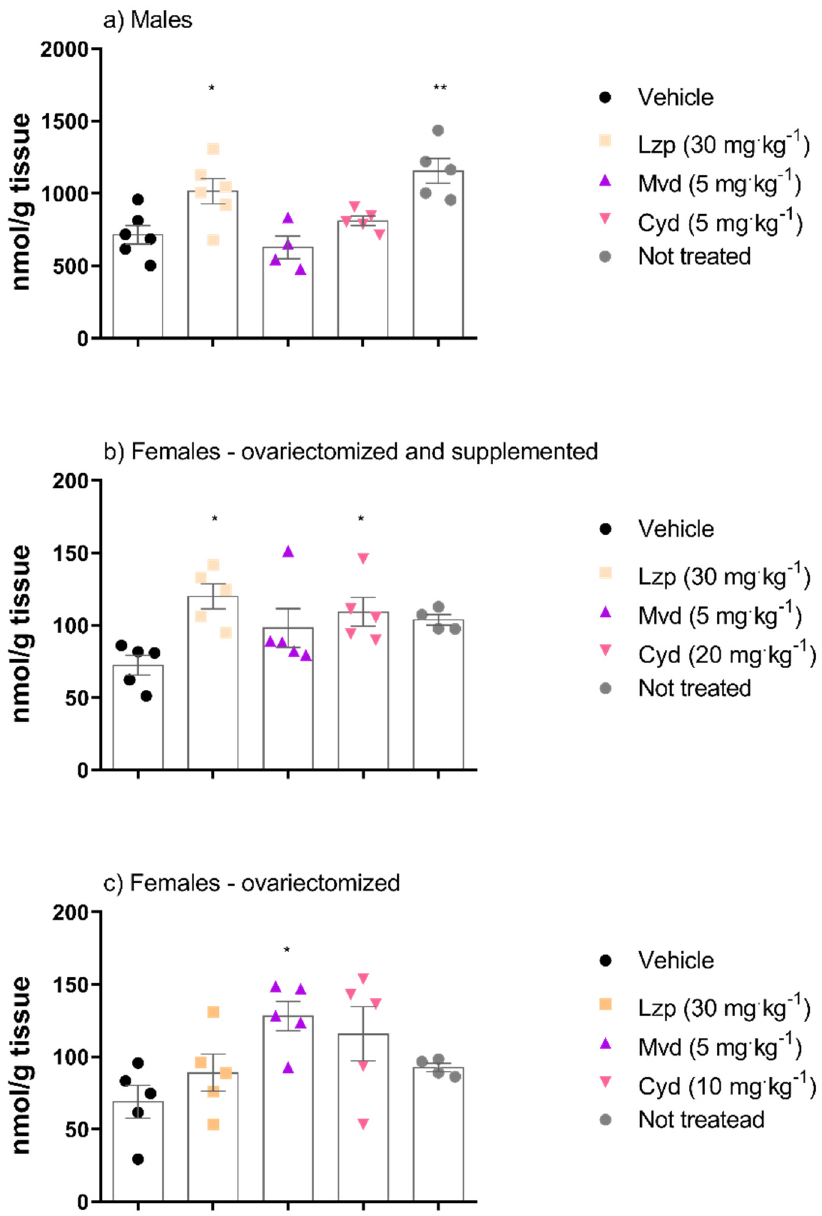
Figure 8. The GSH levels in the stomach of mice treated with malvidin and cyanidin chloride before gastric lesions induced by absolute ethanol in the different groups: ( a ) male animals, ( b ) female animals ovariectomized and supplemented with 17 β -estradiol (500 µ g/kg) and ( c ) group of ovariectomized female animals without supplementation. Data are presented as mean ± S.E.M. ANOVA followed by the Dunnett’s test; where * p < 0.05 and ** p < 0.01, compared to the respective vehicle